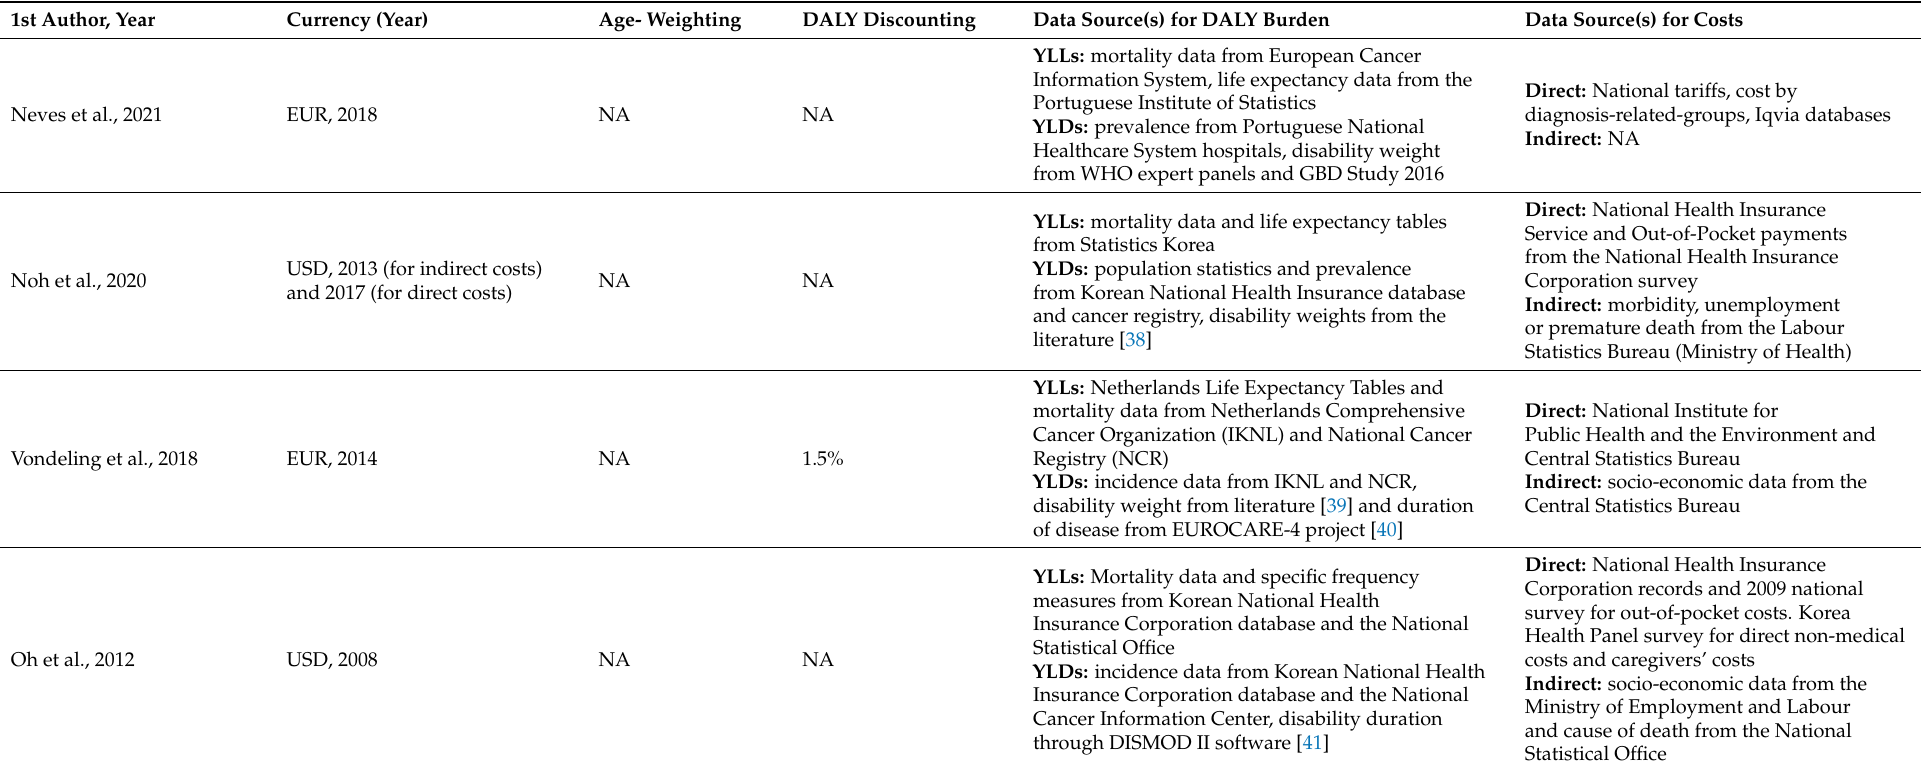
Table 2. Descriptive characteristics of included studies: economic parameters and data sources. White rows indicate studies performing separately economic analyses related to costs and DALYs (included in the quantitative synthesis), whereas shaded rows contain studies that deduce costs starting from DALYs (not included in the